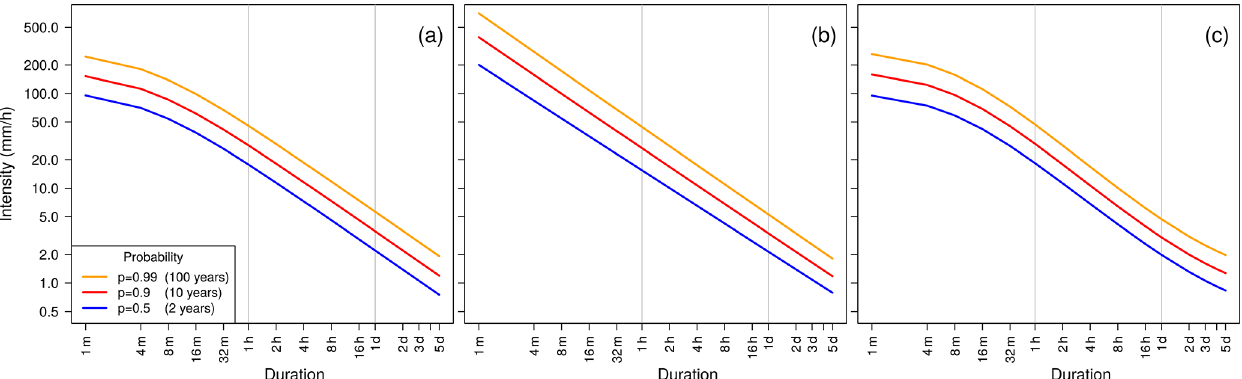
Figure 2. IDF curve examples showing the visualization of different IDF curve features. ( a ) Curvature for short durations. ( b ) Multiscaling. ( c ) Curvature for short durations, flattening for long durations, and